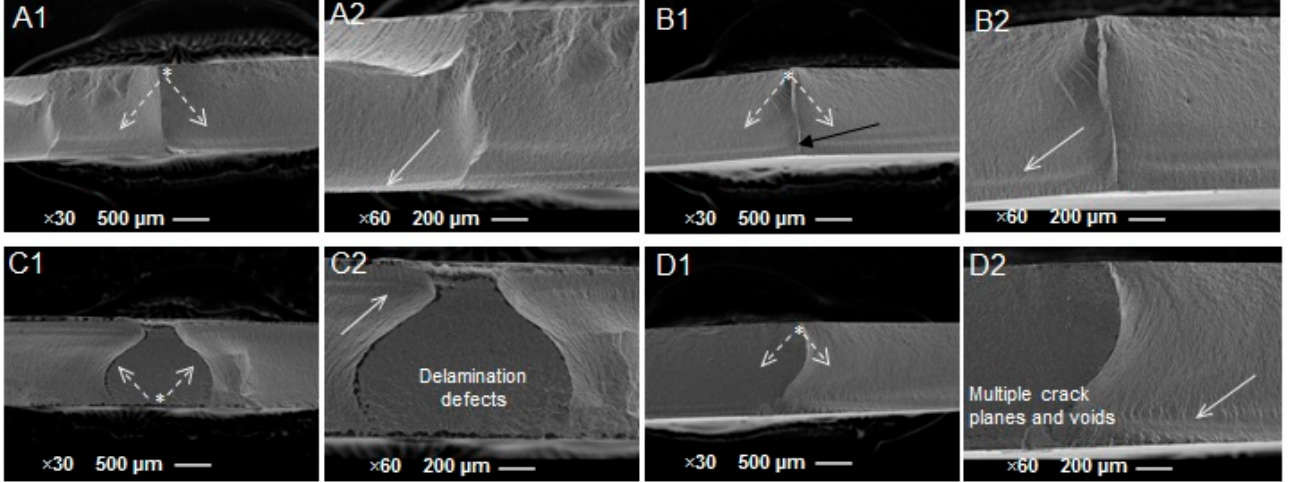
Figure 4. SEM images of fractured surface of representative LU specimen following BFS test: ( A1 ) control specimen shows the origin (asterisk) and extent of the crack (dotted white line); ( A2 ) higher magnification shows compression curl (solid white arrow) as well as multiple crack planes and voids; ( B1 ) MP specimen shows the origin and extent of the crack and crack arrest line (solid black line). ( B2 ) Higher magnification shows compression curl as well as void at the origin of the crack left behind by the loading ball. ( C1 ) OG specimen shows the origin and extent of the crack; ( C2 ) higher magnification showing compression curl. The quick fracture of the specimens leads to the formation of rough surfaces featured in the multiple crack planes and delamination defects; ( D1 ) MP+PP specimen shows the origin and extent of the crack. ( D2 ) Multiple crack planes are shown that are also a feature of fast fracture, and compression curl is also observed (solid white line).